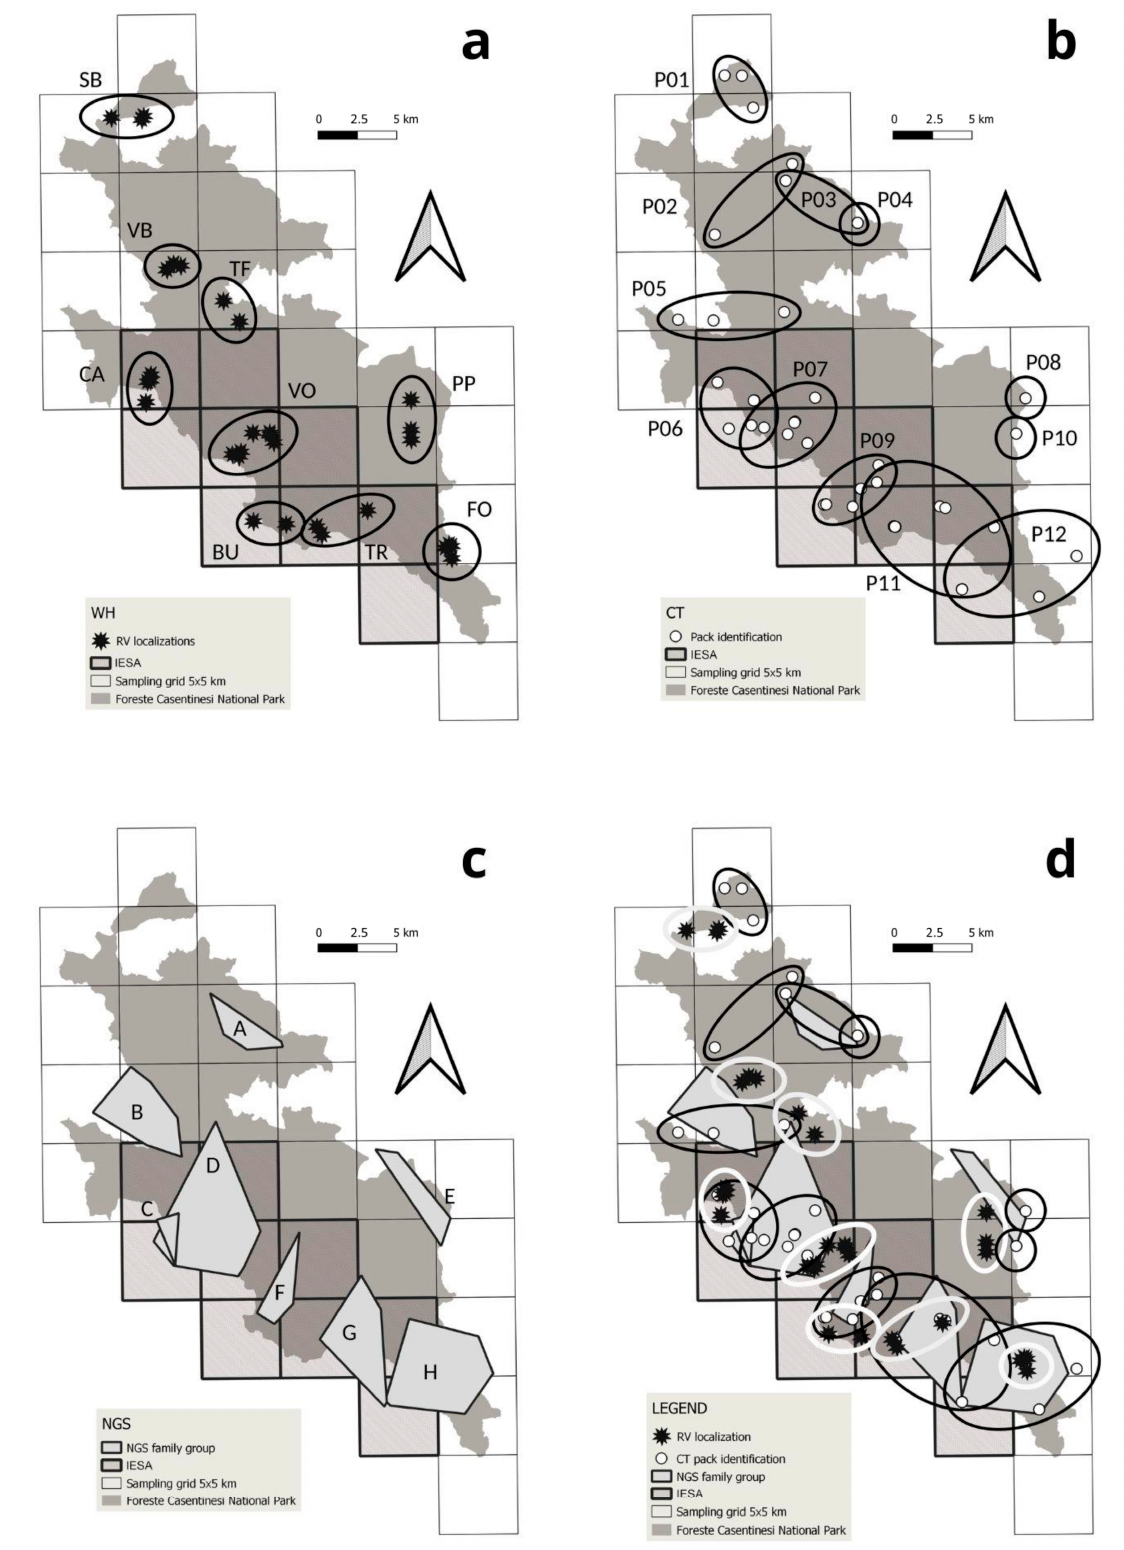
Figure 4. Wolf packs’ identifications with different techniques: ( a ) with wolf howling, we identified 9 packs (named after locality abbreviations); ( b ) with camera trapping, we identified 12 packs (named from P01 to P12); ( c ) with non-invasive genetic sampling, we identified 8 packs (named from A to H); ( d ) spatial comparison among different